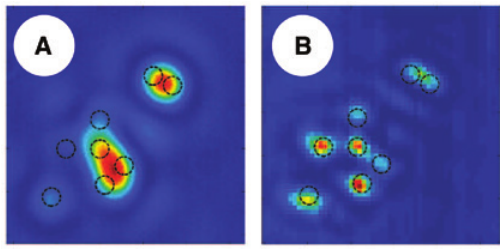
Figure 12: The comparison of the imaging of a cluster of 210 nm diameter holes using (A) a conventional lens with NA = 1.4 and (B) an SOL. After